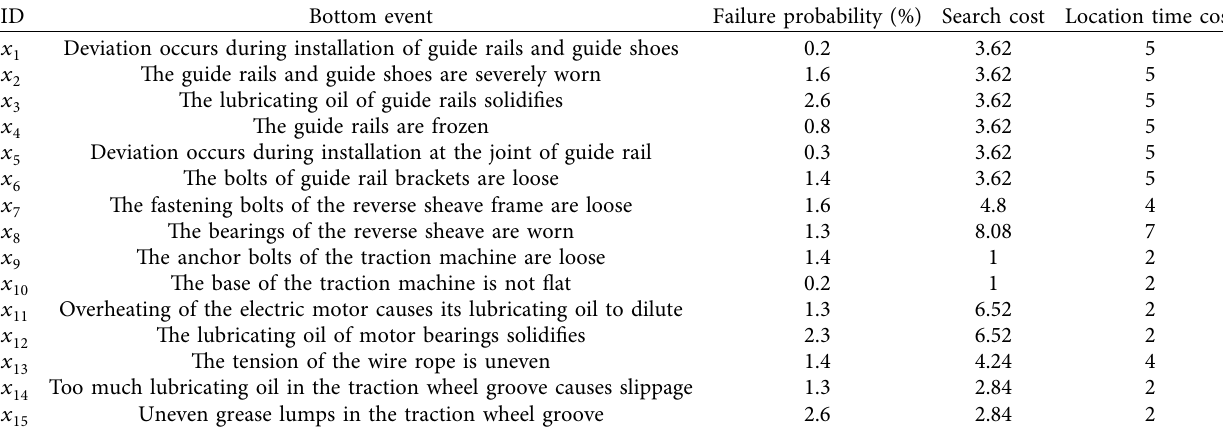
Table 3: The score of the static